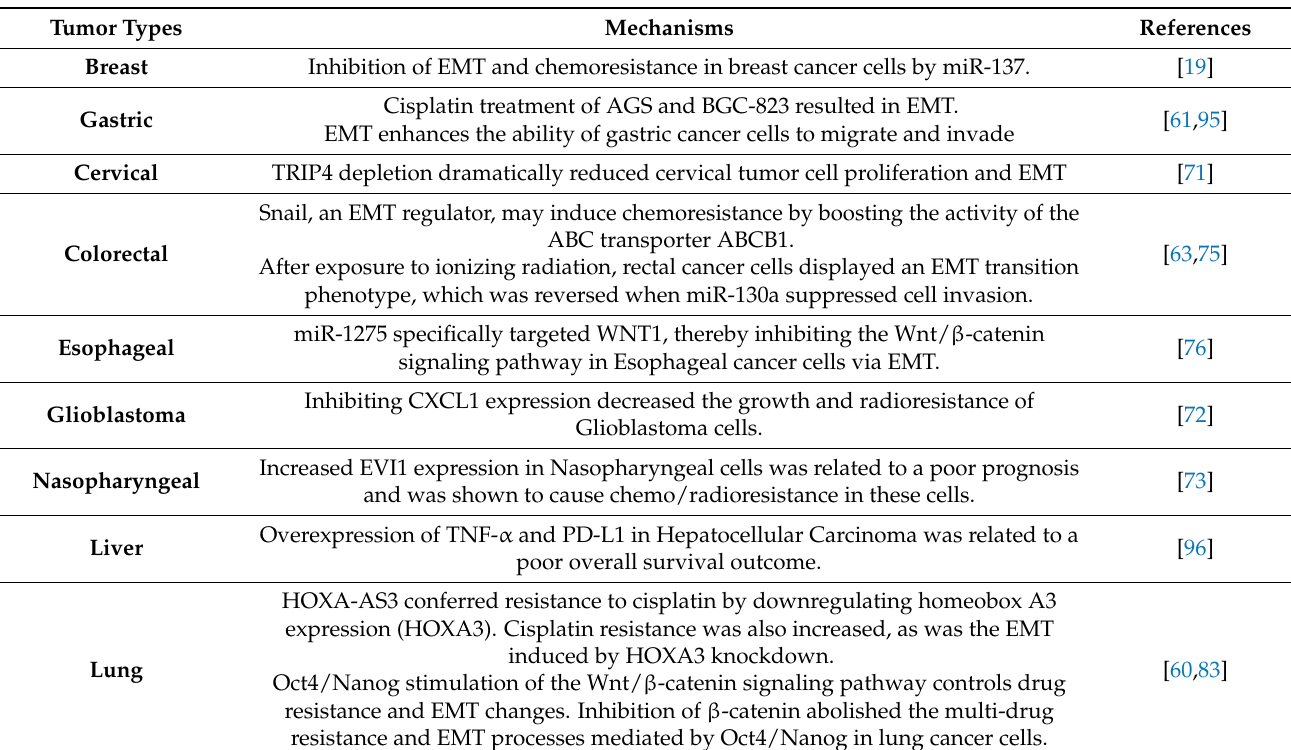
Table 1. EMT-mediated therapeutic